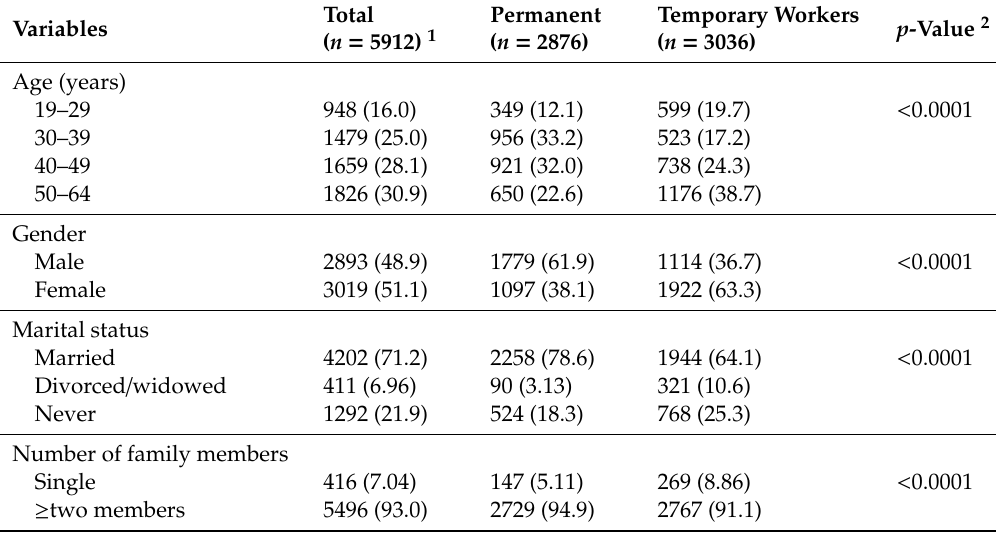
Table 1. Characteristics of permanent and temporary workers ( n =